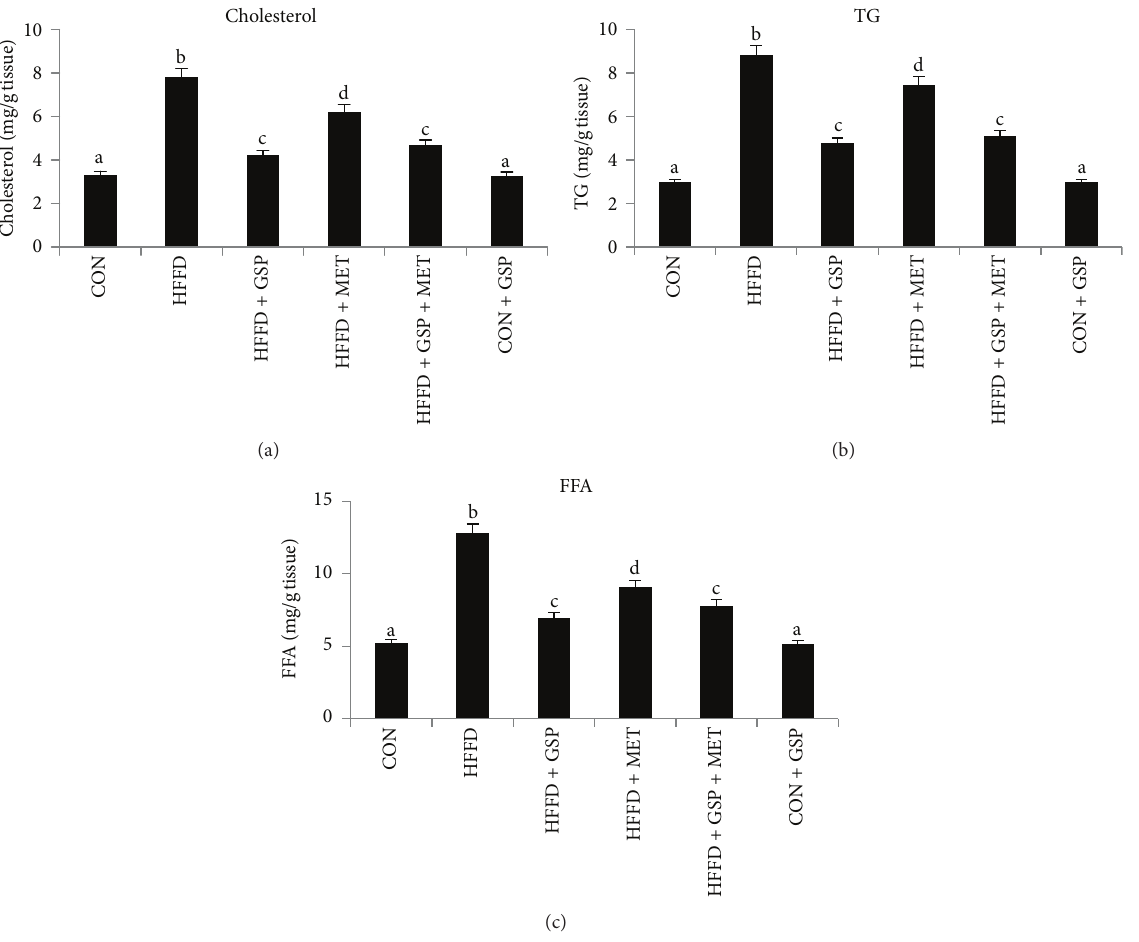
Figure 3: Effect of GSP and MET on levels of cholesterol (a), TG (b), and FFA (c) in liver of experimental animals. Data are expressed as means ± S.D.of6ratsfromeachgroup.Statisticalsignificancebetweenthegroups,denotedbydifferentalphabets,wasdeterminedbyone-way ANOVA of significance set at 𝑃 < 0.05 .